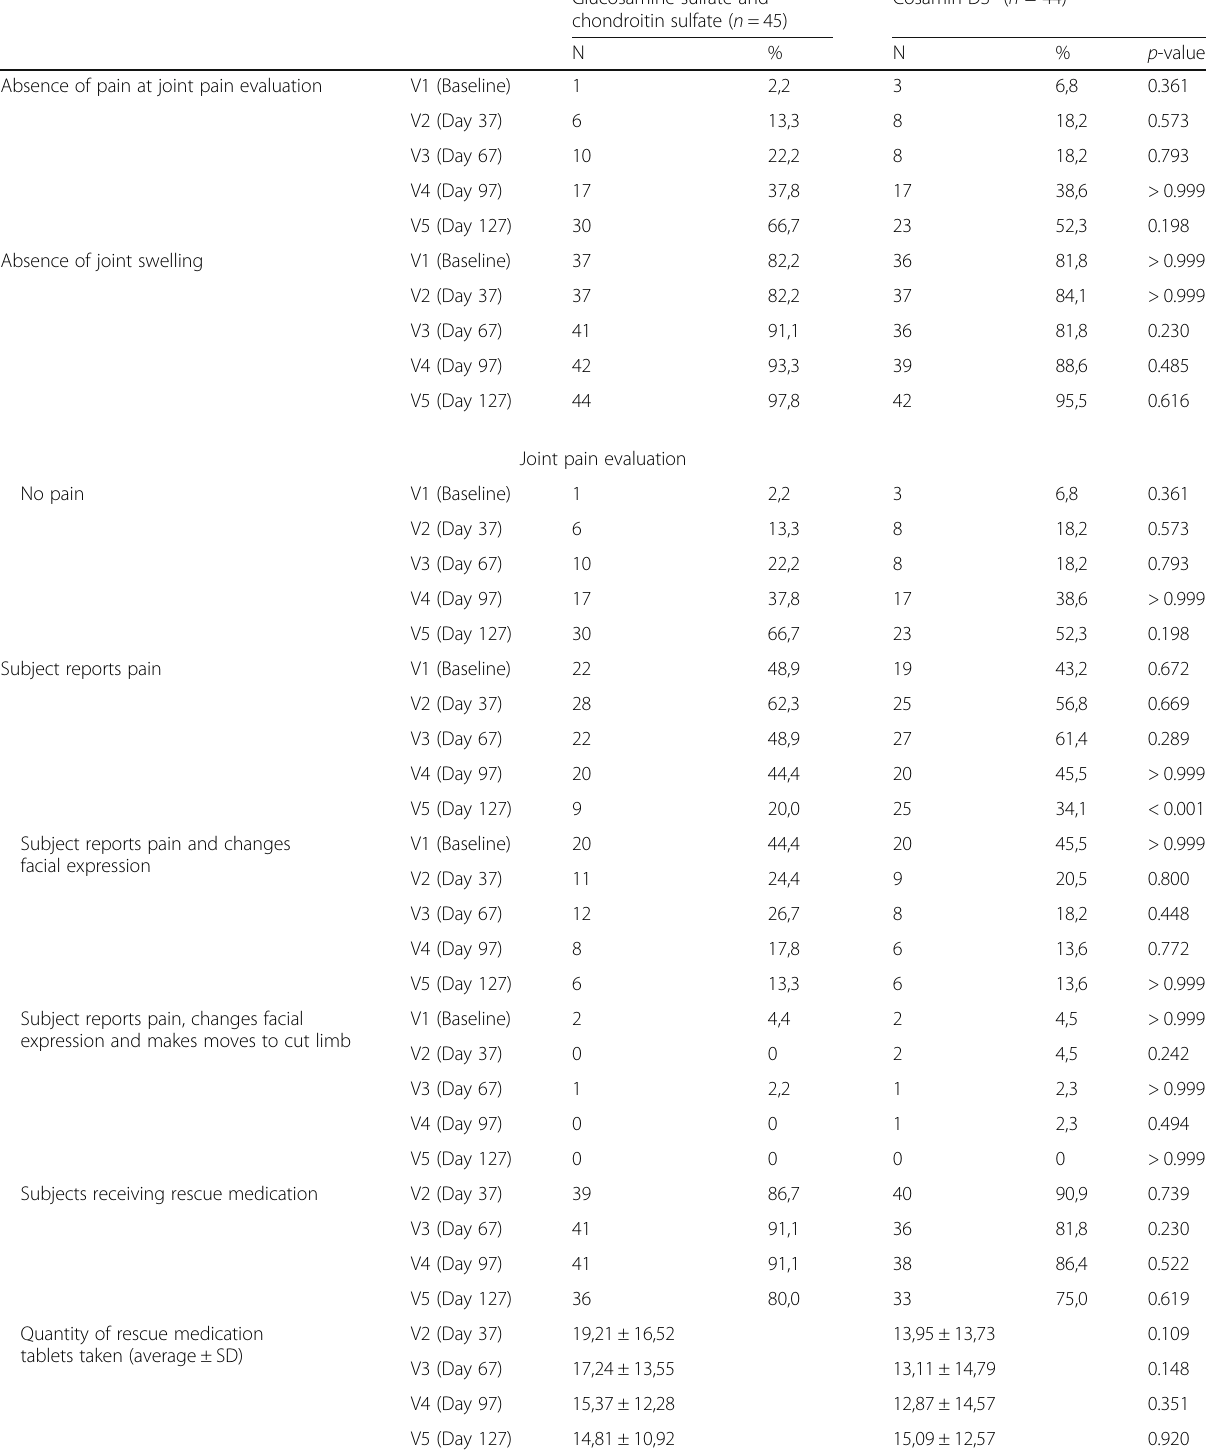
Table 3 Evaluation of joint pain and swelling and of the use of rescue therapy per visit in ITT population ( N =